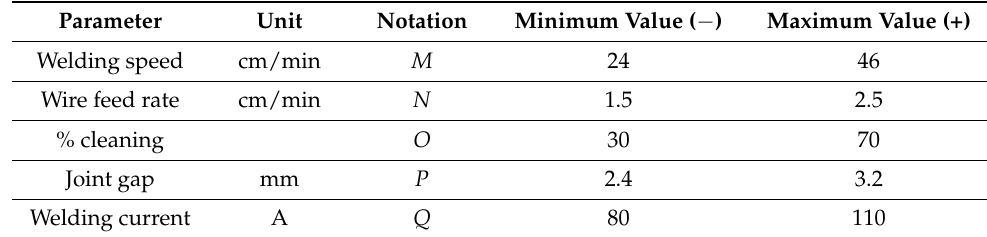
Table 5. Input parameters for TIG process [3].